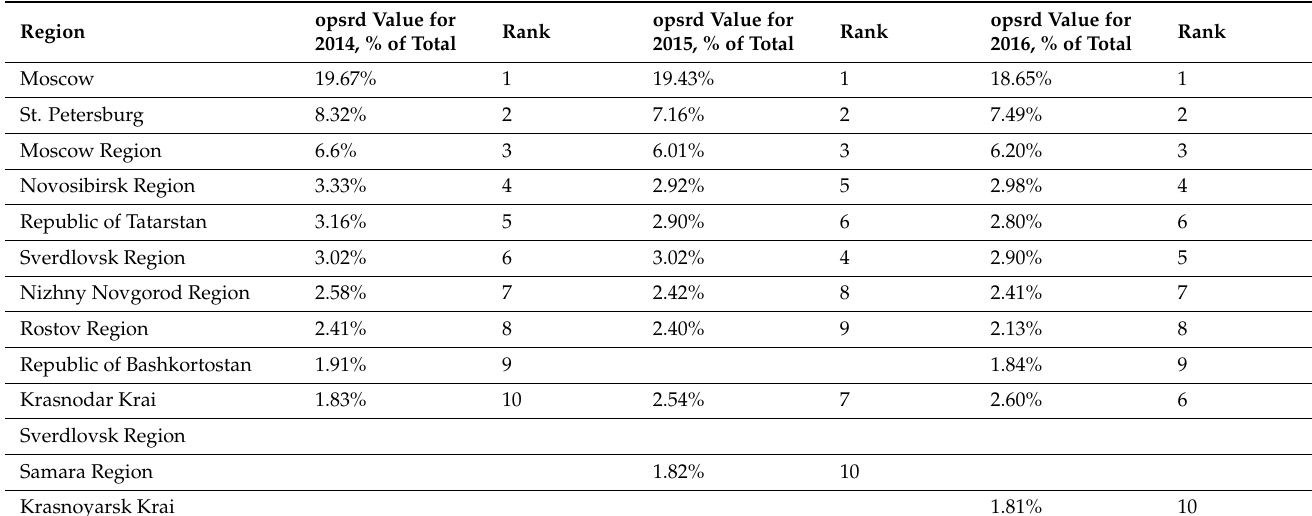
Table 6. Top 10 regions with the highest oprsd indicator for